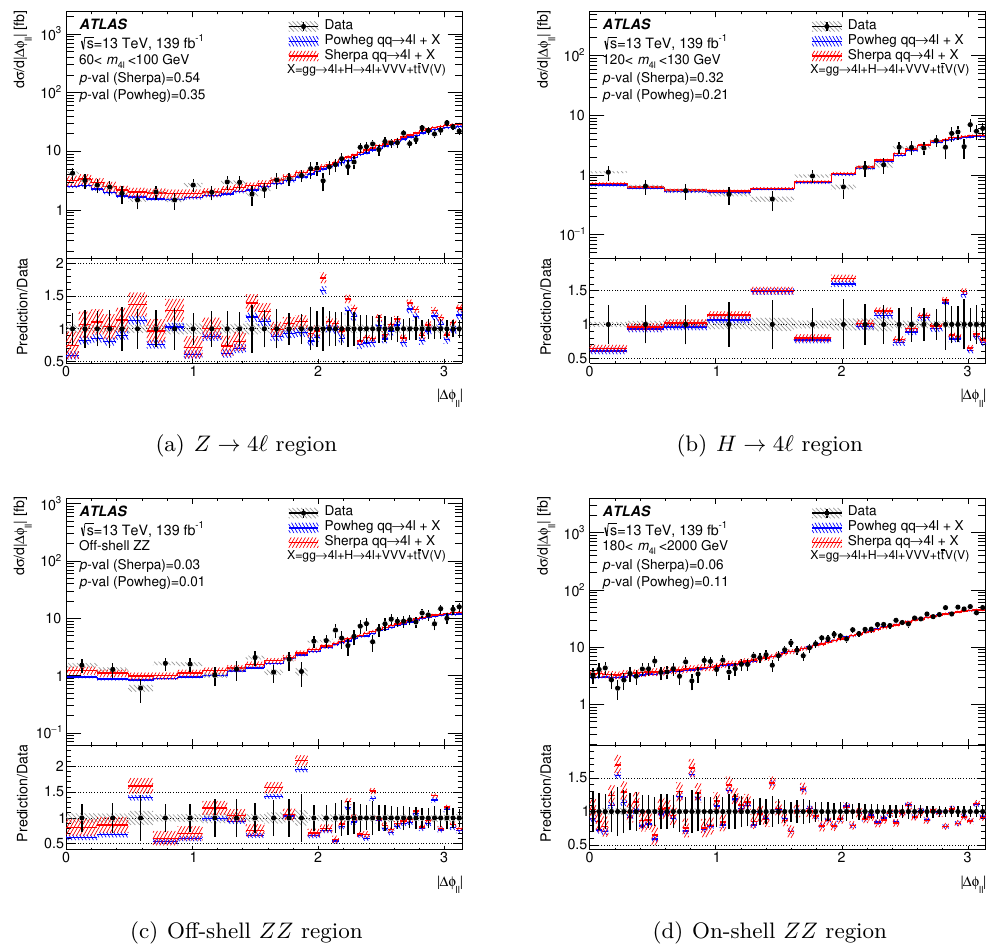
Figure 9 . Differential cross-section as a function of | ∆ φ ‘‘ | in the four m 4 ‘ regions. The measured data (black points) are compared to the SM prediction using either Sherpa (red, with red hashed band for the uncertainty) or Powheg + Pythia8 (blue, with blue hashed band for the uncertainty) to model the q ¯ q → 4 ‘ contribution. The error bars on the data points give the total uncertainty and the grey hashed band gives the systematic uncertainty. The p -value is the probability for the χ 2 , with the number of degrees of freedom equal to the number of bins in the distribution, to have at least the observed value, given the SM prediction. The lower panel shows the ratio of the SM predictions to the